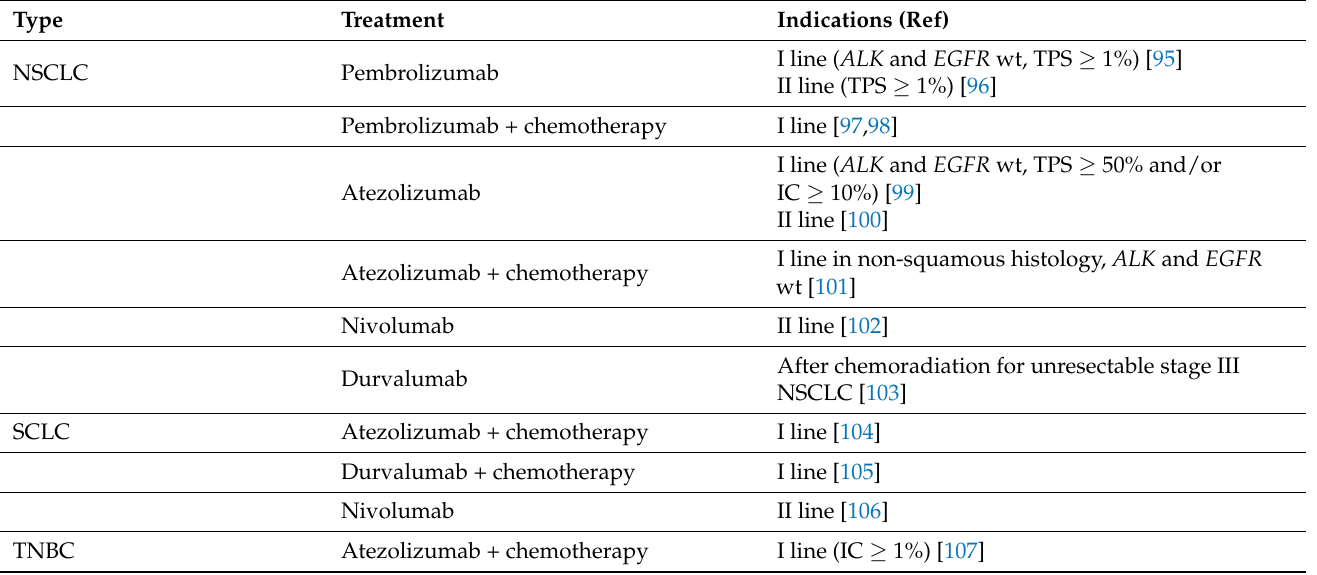
Table 2. Current indications for anti PD1/PD-L1 therapy in different advanced/metastatic tumor types: NSCLC: non-small cell lung carcinoma; SCLC: small cell lung carcinoma; TNBC: triple negative breast carcinoma; CSCC: cutaneous squamous cell carcinoma; RCC: renal cell carcinoma; UC: urothelial carcinoma; HCC: hepatocellular carcinoma; GEJ: gastro-esophageal junction; MSI: microsatellite instability; dMMR: mismatch repair deficient; HNSCC: head and neck squamous cell carcinoma; HL: Hodgkin lymphoma; PMLBCL: primary mediastinal large B cell lymphoma; wt: wild-type; TPS: tumor proportion score; CPS: combined positive score; IC: tumor-infiltrating immune cell; pembrolizumab, nivolumab, cemiplimab: anti-PD-1; atezolizumab, durvalumab, avelumab: